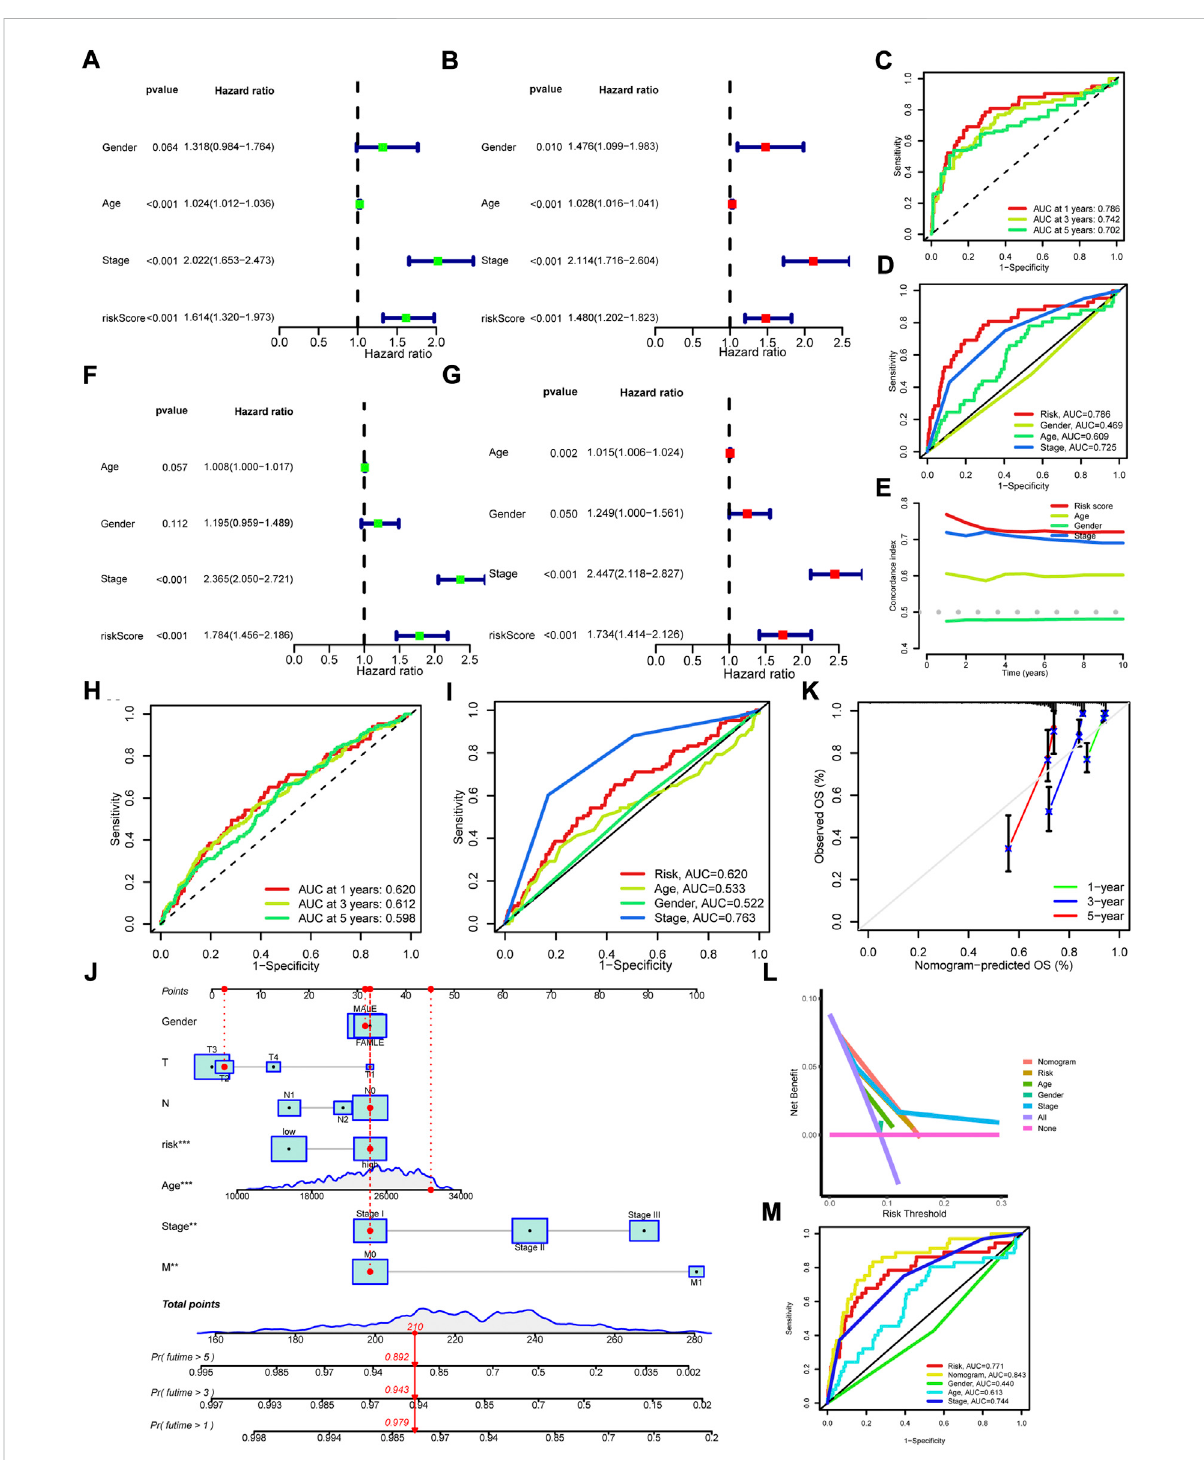
FIGURE 4 Assessment of cuproptosis-related prognosis model and construction of Nomogram. (A,B) The univariate and multivariate Cox regression analysisofoverallsurvivalinallsamples. (C) The1-,3-,and5-yearsROCofriskscoreinallsamples. (D) The1-yearROCofriskscore,age,genderand stage. (E) The C-index of risk score, age, gender and stage. (F,G) The univariate and multivariate Cox regression analysis of overall survival in the external validation set. (H) The 1-, 3-, and 5-years ROC of risk score in the external validation set. (I) The 1-year ROC of risk score, age, gender and stage in the external validation set. (J) The nomogram was constructed with risk score, age, gender, T, N, M, and stage to predict the overall survival rate of 1-, 3- and 5-years. (K) The calibration curves for predicting the probability of 1-, 3- and 5-years. (L) DCA curves for assessing the clinical utility of the nomogram. (M) The 1-year ROC of nomogram, risk score, age, gender and